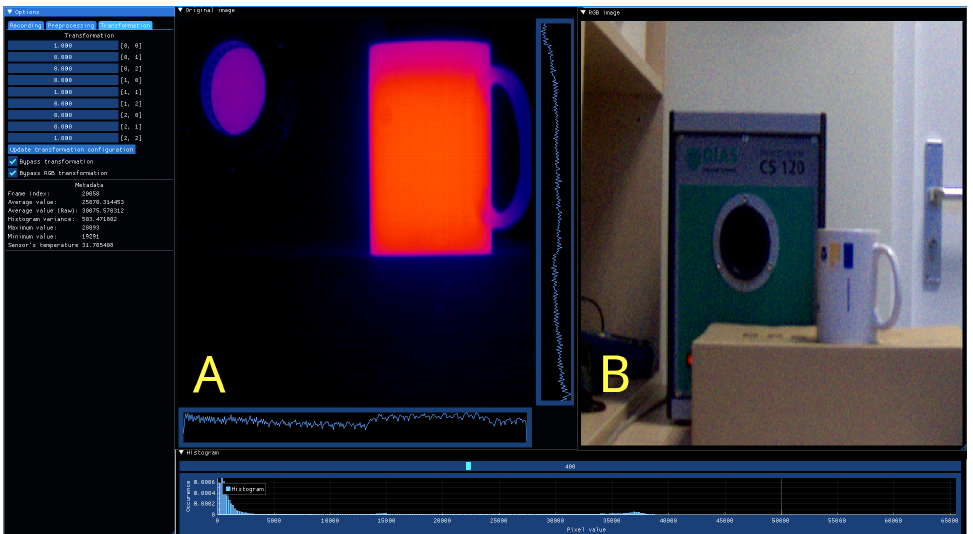
Figure 9. Visualization software with controls for geometric transformation IP core. IR image of a hot cup and a colder blackbody patch after FPN correction in ( A ) and RGB image in ( B